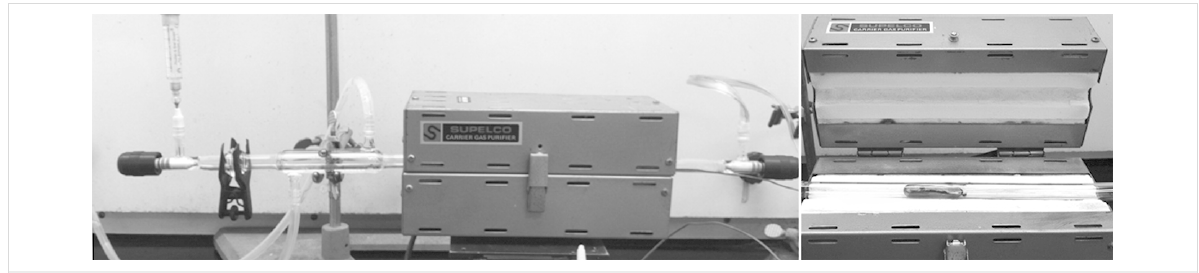
Figure 8: Tubular reactor used in the catalytic reduction reaction.